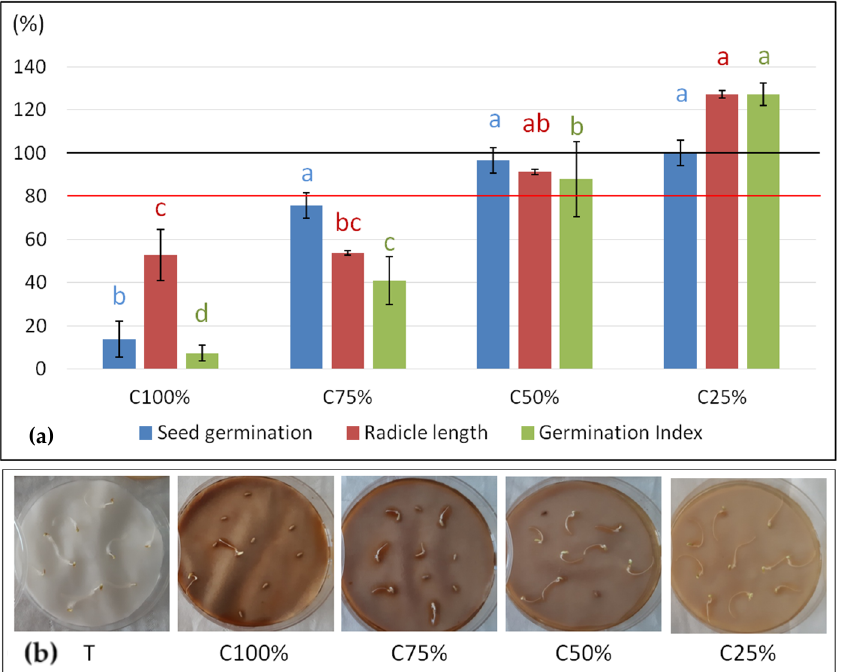
Figure 1. Phytotoxicity test, performed on Lactuca sativa L. seeds, using aqueous extracts from compost (C) undiluted (100%) and diluted (75%, 50% and 25%). ( a ) Mean values of seed germination, root elongation and germination index are expressed as percentages relative to the control (n = 3). Bars represent SD of the mean. Different letters indicate significant differences ( p = 0.05) among aqueous extracts, according to factorial ANOVA combined with Tukey post-hoc test. The black and red lines designate the percentages of the control and the phytotoxicity threshold, respectively. ( b ) Representative pictures of Petri dishes with seeds germinated in distilled water as control (T) and in all aqueous extracts after 48 h of dark incubation.